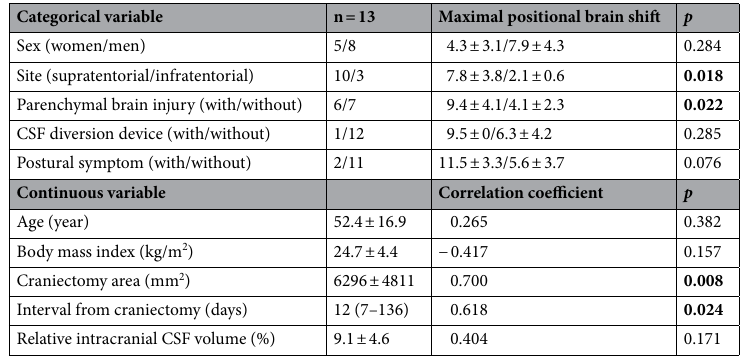
Table 3. Sub-analysis of post-craniectomy patients. Significant values are in [bold]. Data are presented as n, mean ± standard deviation, or median (interquartile range). CSF cerebrospinal fluid.